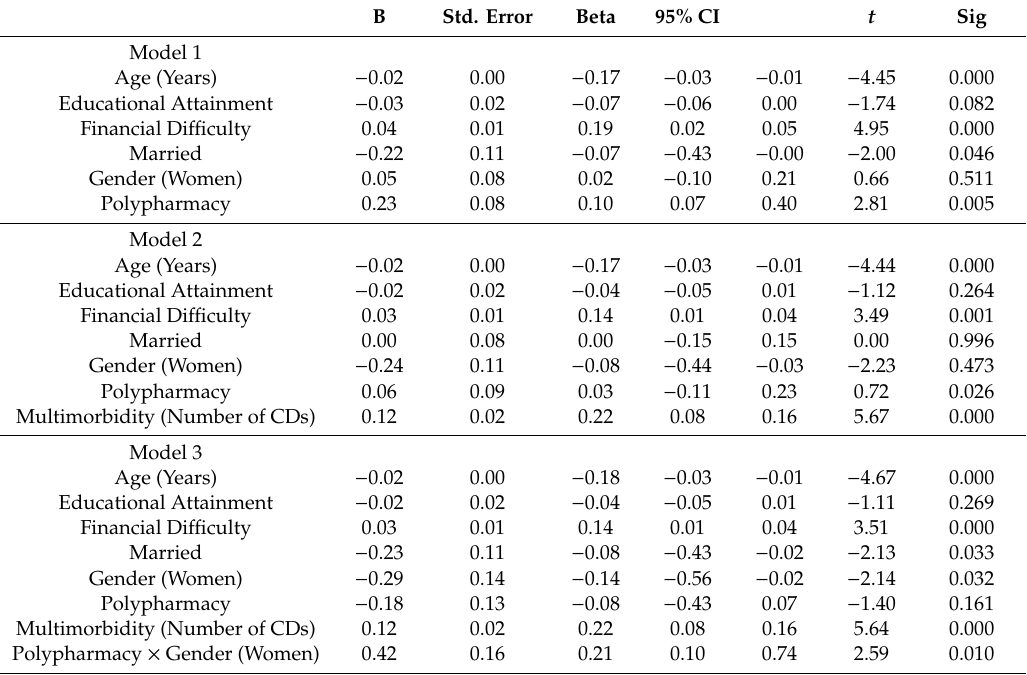
Table 3. Linear regressions on the associations between gender, polypharmacy, and self-rated health in the pooled